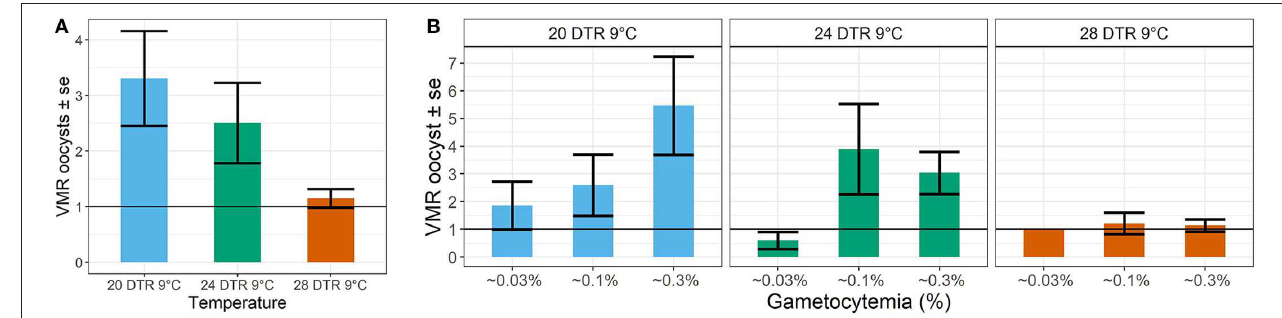
FIGURE 5 | Effect of temperature (A) and gametocyte density (B) on the distribution of oocyst burdens across individual (infected) midguts at the three temperatures using the Variance to Mean Ratios (VMR) as the measure of dispersion ( s 2 : m ). Values represents means ± standard error (se) of the VMR from three biological